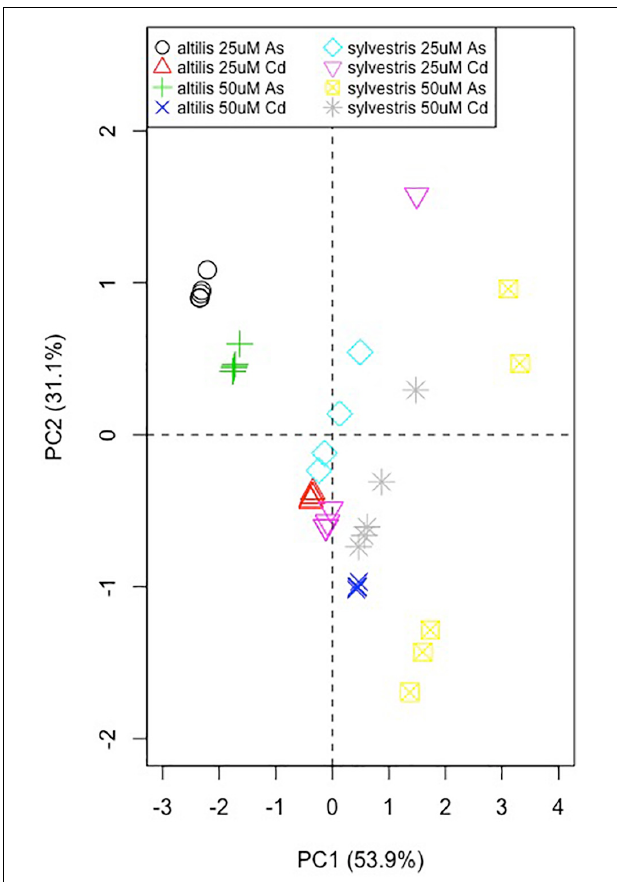
FIGURE 9 | Principal component analysis using the RT-qPCR fold-change values of the five metal-response–associated genes along with the shoot and root